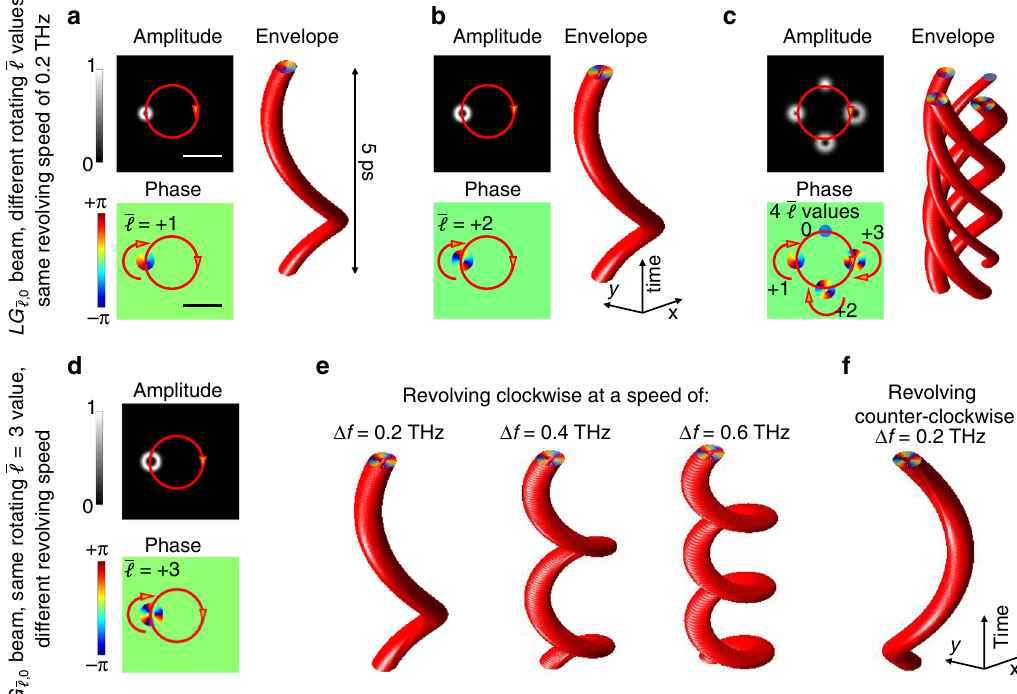
Fig. 5 Independent control of two momenta of the spatiotemporal beams. a – c The 2D amplitude and phase pro fi les at time t = 0, and the envelope structures in ( x , y , t ) coordinates of the generated rotating-revolving LG (cid:1) ‘; 0 beams with different rotating (cid:1) ‘ values but the same revolving speed of 0.2 THz. Scale bar, 1 mm. The phasefronts are exp( i θ ) and exp( i 2 θ ) in one circle around the beams ’ center intensity nulls in ( a ) and ( b ), respectively; panel ( c ) is a single beam combining an array of four rotating-revolving LG (cid:1) ‘; beams, where (cid:1) ‘ ¼ 0 ; 1 ; 2 ; 3. See Supplementary Fig. 2 for details of the spatial LG ‘; p mode 0 distributions used for superposition. d The corresponding pro fi les/structures of the generated rotating-revolving LG (cid:1) ‘; 0 beams with the same (cid:1) ‘ = 3 value but a different revolving speed. e Examples of an LG 3,0 beam revolving clockwise at different speeds from 0.2 to 0.6 THz; and f an LG 3,0 beam revolving counterclockwise at a speed of 0.2 THz. Except for the varied parameters and the spatial/frequency spectra, all the other parameters are the same as those in Fig.